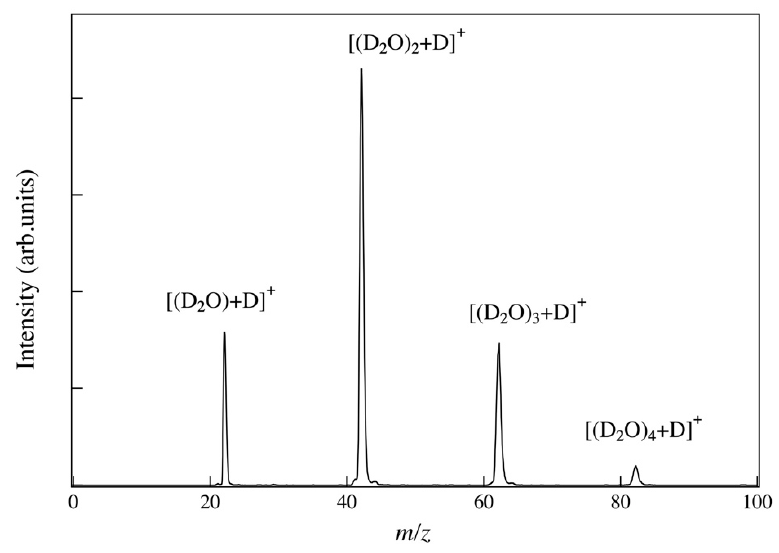
Figure 5. Mass spectra of ions detected from Ag sample under bombardment with the water cluster (D 2 O) 900 + ion at an incident angle of 45°.